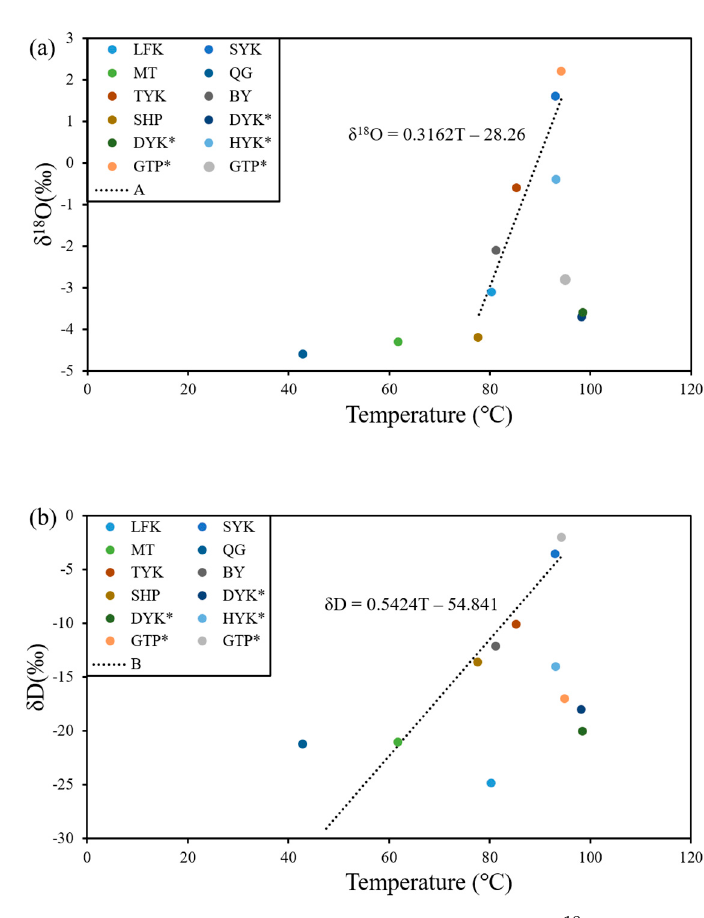
Figure 9. The relationship between the spring temperature and ( a ) δ 18 O and ( b ) δ D in the TVG.